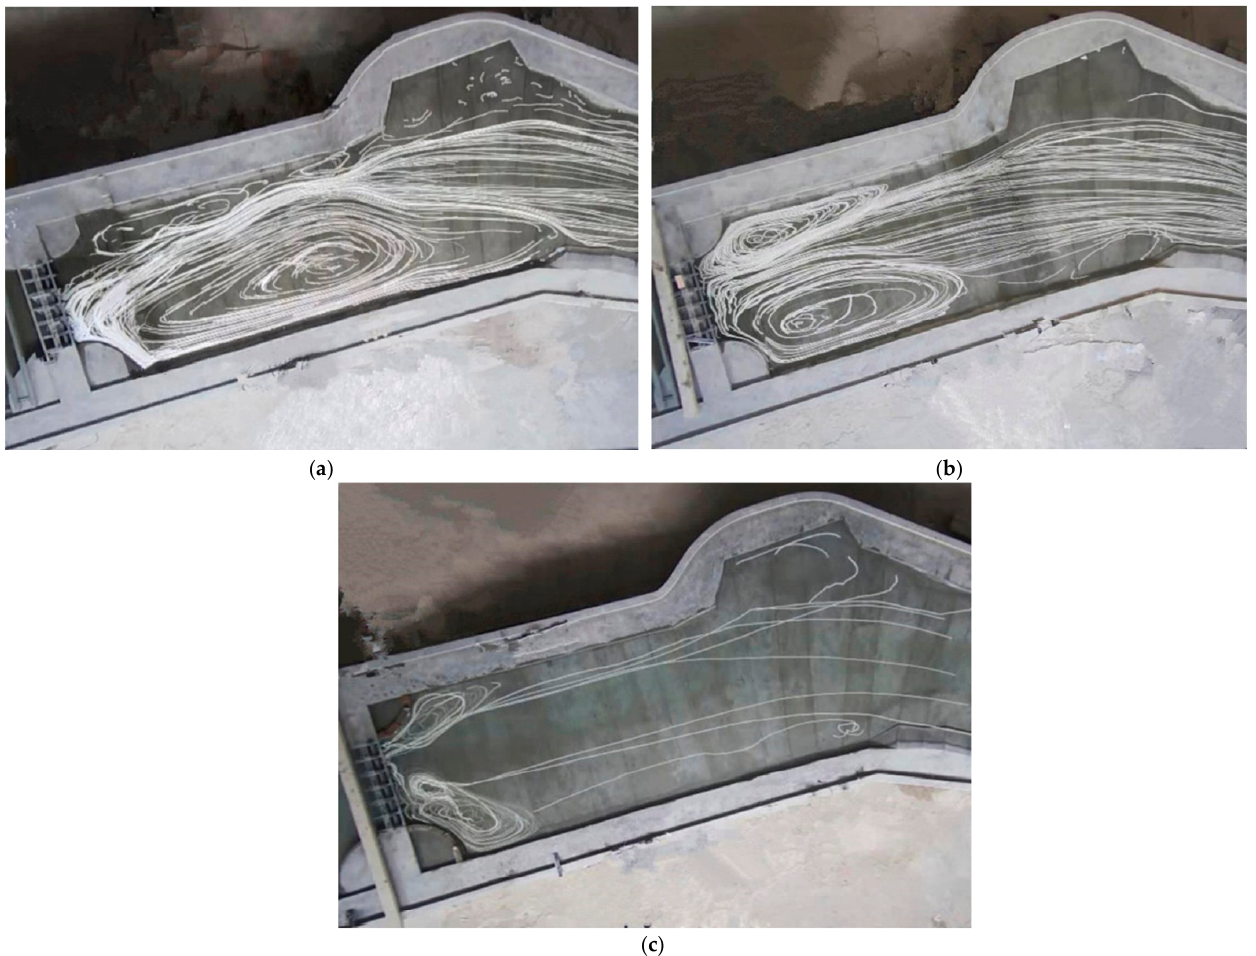
Figure 12. Flow patterns upstream of the sluice structure: ( a ) case 1; ( b ) case 2; ( c ) case 3. The flow runs from right to left.